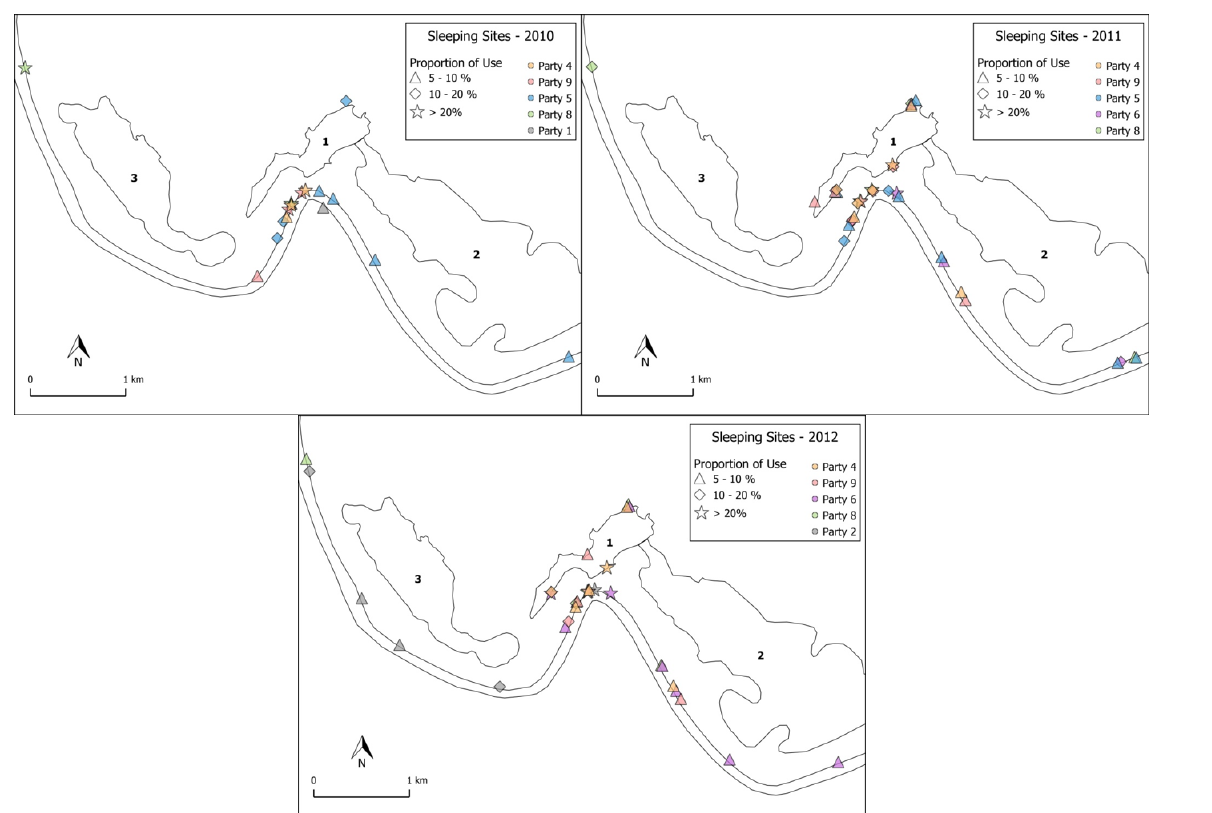
Figure 10. Distribution of main sleeping sites in 2010, 2011, and 2012. Star shapes depict locations that had been used in > 20% of all sleeping events. Diamond shapes represent 10%–20%, while triangles represent 5%–10% of all sleeping events. Sleeping locations < 5% are not depicted. Numbers depict the various wetland features: 1 – Mare Simenti, 2 – temporary wetland Simenti, 3 – temporary wetland Mare Kountadala. The two parallel lines represent the Gambia